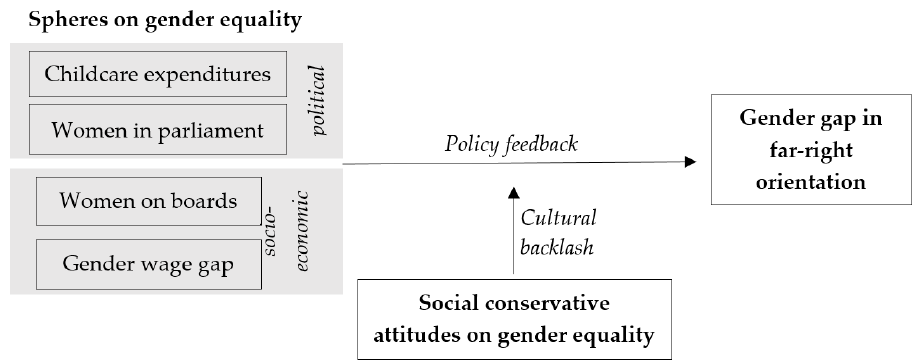
Figure 1. Theoretical framework.